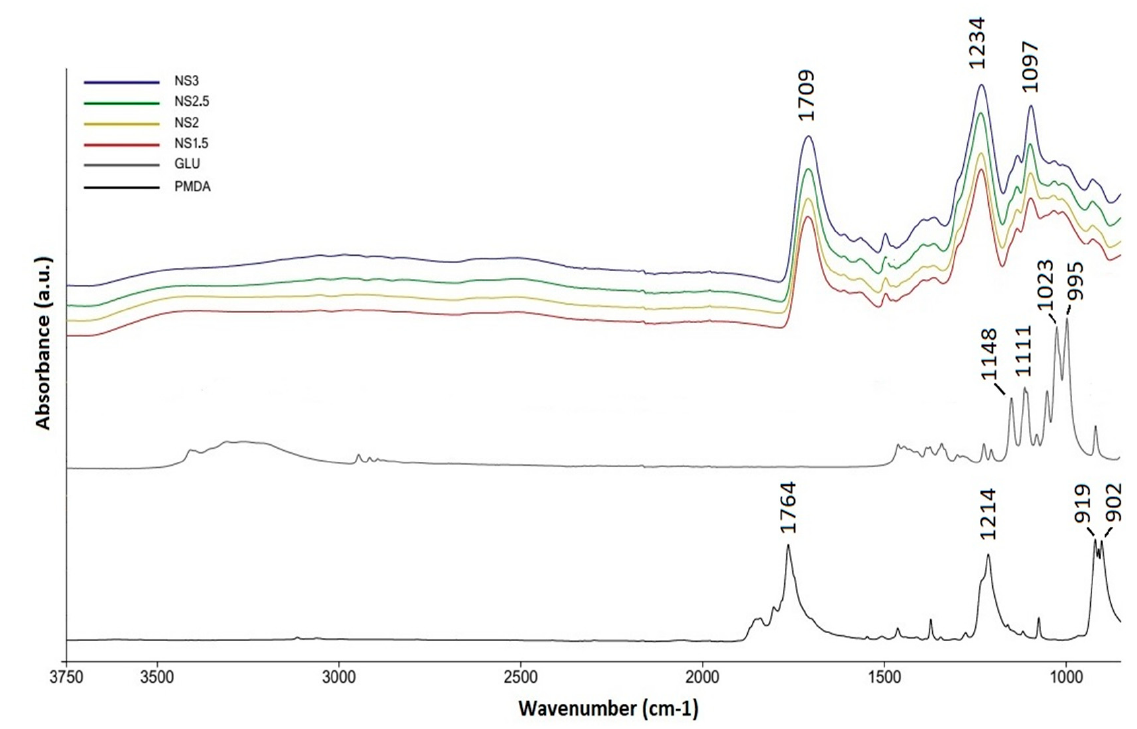
Figure 1. FTIR spectra of nanosponges obtained with different PMDA/GLU molar ratios (1.5, 2, 2.5 and 3) as compared to FTIR spectra of PMDA and GLU.